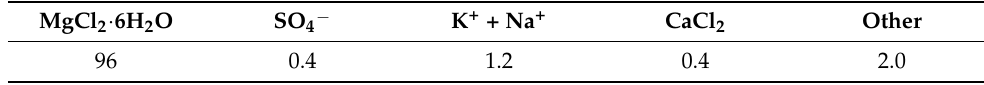
Table 2. Magnesium chloride chemical